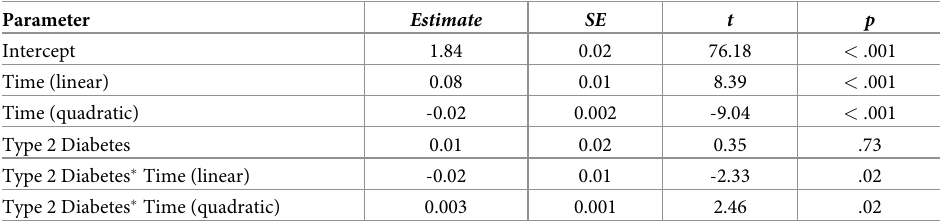
Note: Effects of age, gender, BMI and hypertensive medication were controlled